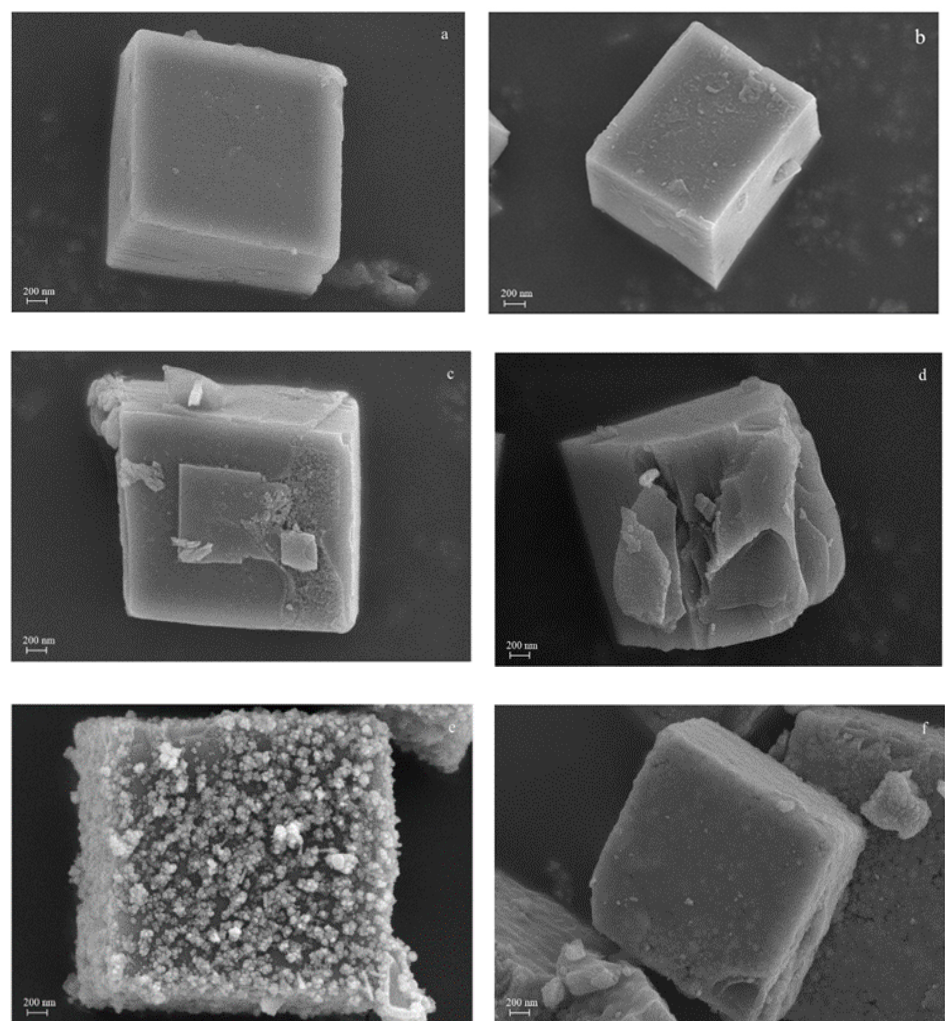
Figure 2. SEM patterns of SAPO-34 ( a ), H-SAPO-34-0.01 ( b ), H-SAPO-34-0.1 ( c ), H-SAPO-34-0.125 ( d ), MnO x /SAPO-34 ( e ) and MnO x /H-SAPO-34-0.1 ( f ).